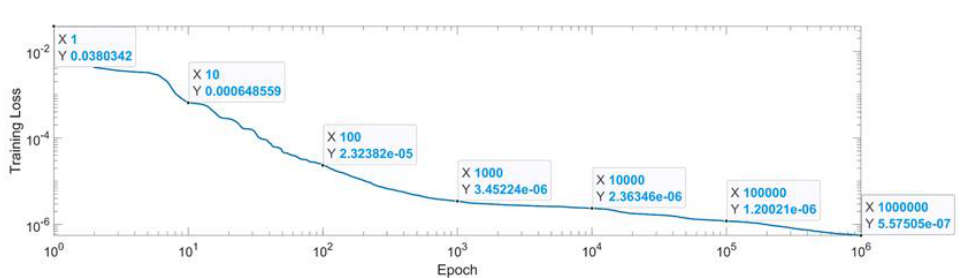
Figure 31. Convergence of the neural network for workspace (log scale).